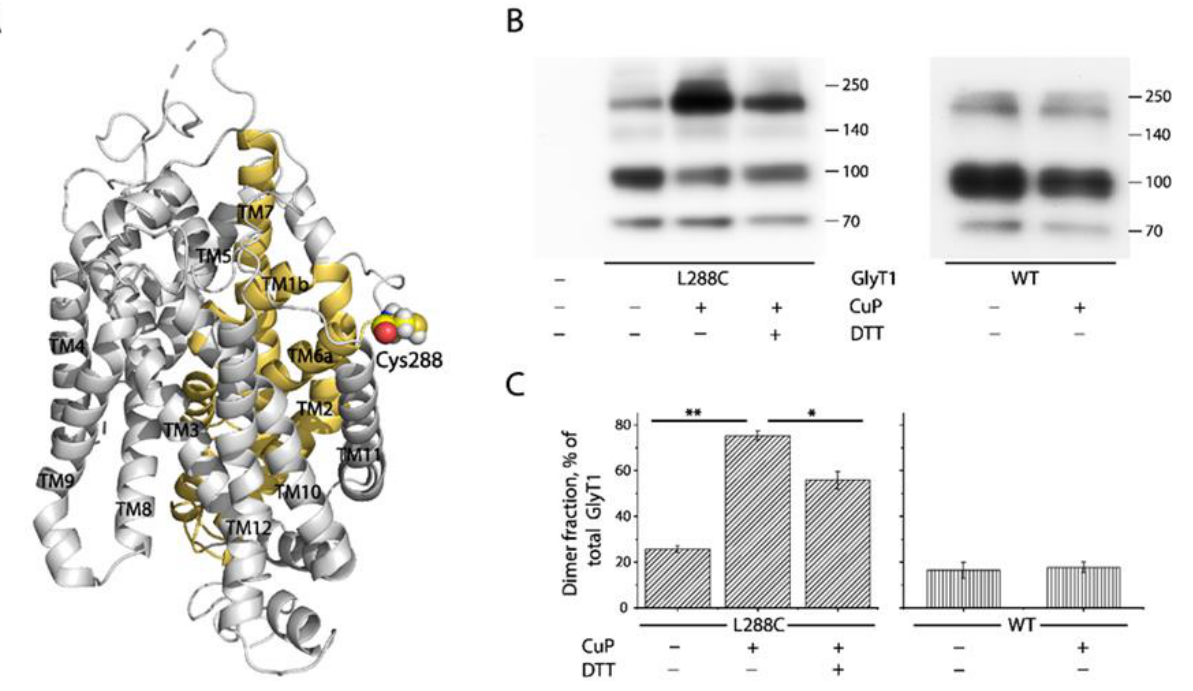
Figure 2. Location of the cysteine replacing Leu288 in GlyT1 and CuP cross-linking of the L288C mutant. ( A ) The cysteine replacing Leu288 in the x-ray structure of GlyT1 in an inward open con- formation (PDB accession code, 6ZPL) [26]. Cys288 (spheres) is located at EL3 near the extracellular end of TM6 in the GlyT1 structure. The bundle domain (TMs 1, 2, 6, and 7) and other part of the protein are colored in golden and gray, respectively. ( B ) Immunoblots of WT (right panel) and L288C (left panel) with or without CuP treatment. HEK293 cells stably expressing WT or L288C were treated with 100 μM CuP at 22 °C for 15 min and the cross -linking reaction was then quenched by incubating them with 10 mM N-ethylmaleimide for 15 min. FLAG-tagged GlyT1 in total cell lysates was detected by immunoblot analysis as described under “Materials and Methods”. Numbers on the right of each blot represent molecular masses in kDa of protein standards. ( C ) Quantifi- cation of dimer fraction in total GlyT1. The fully glycosylated dimers ( − 190 kDa) were considered to reside on the cell surface, whereas non-glycosylated dimers were within the cytoplasm. Dimer fraction was expressed as percentage of fully glycosylated dimers in total DAT integrated density value. Results are shown as mean ± SEM averaged from three independent experiments. * p < 0.05; ** p < 0.01.